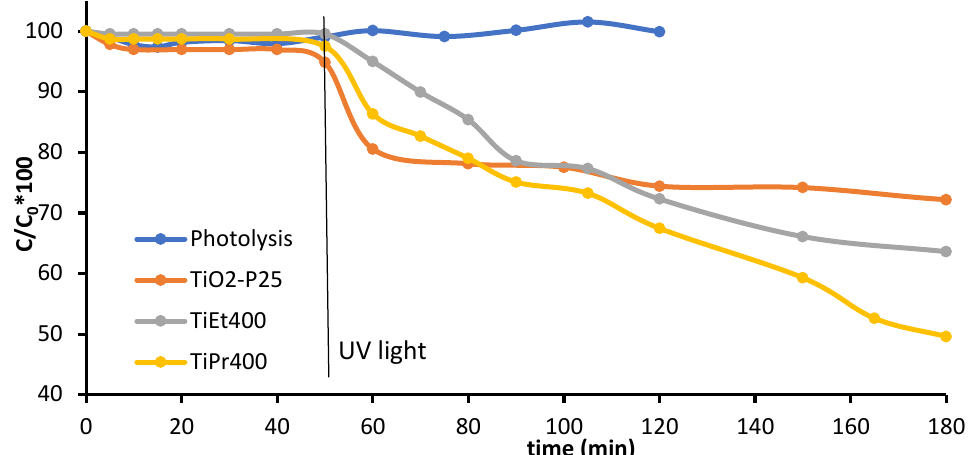
Figure 6. Curves of degradation % vs. the reaction time of the samples. Photolysis and results for TiO 2 −P25 are included for comparison. The vertical line indicates switch on of the UV lamp.